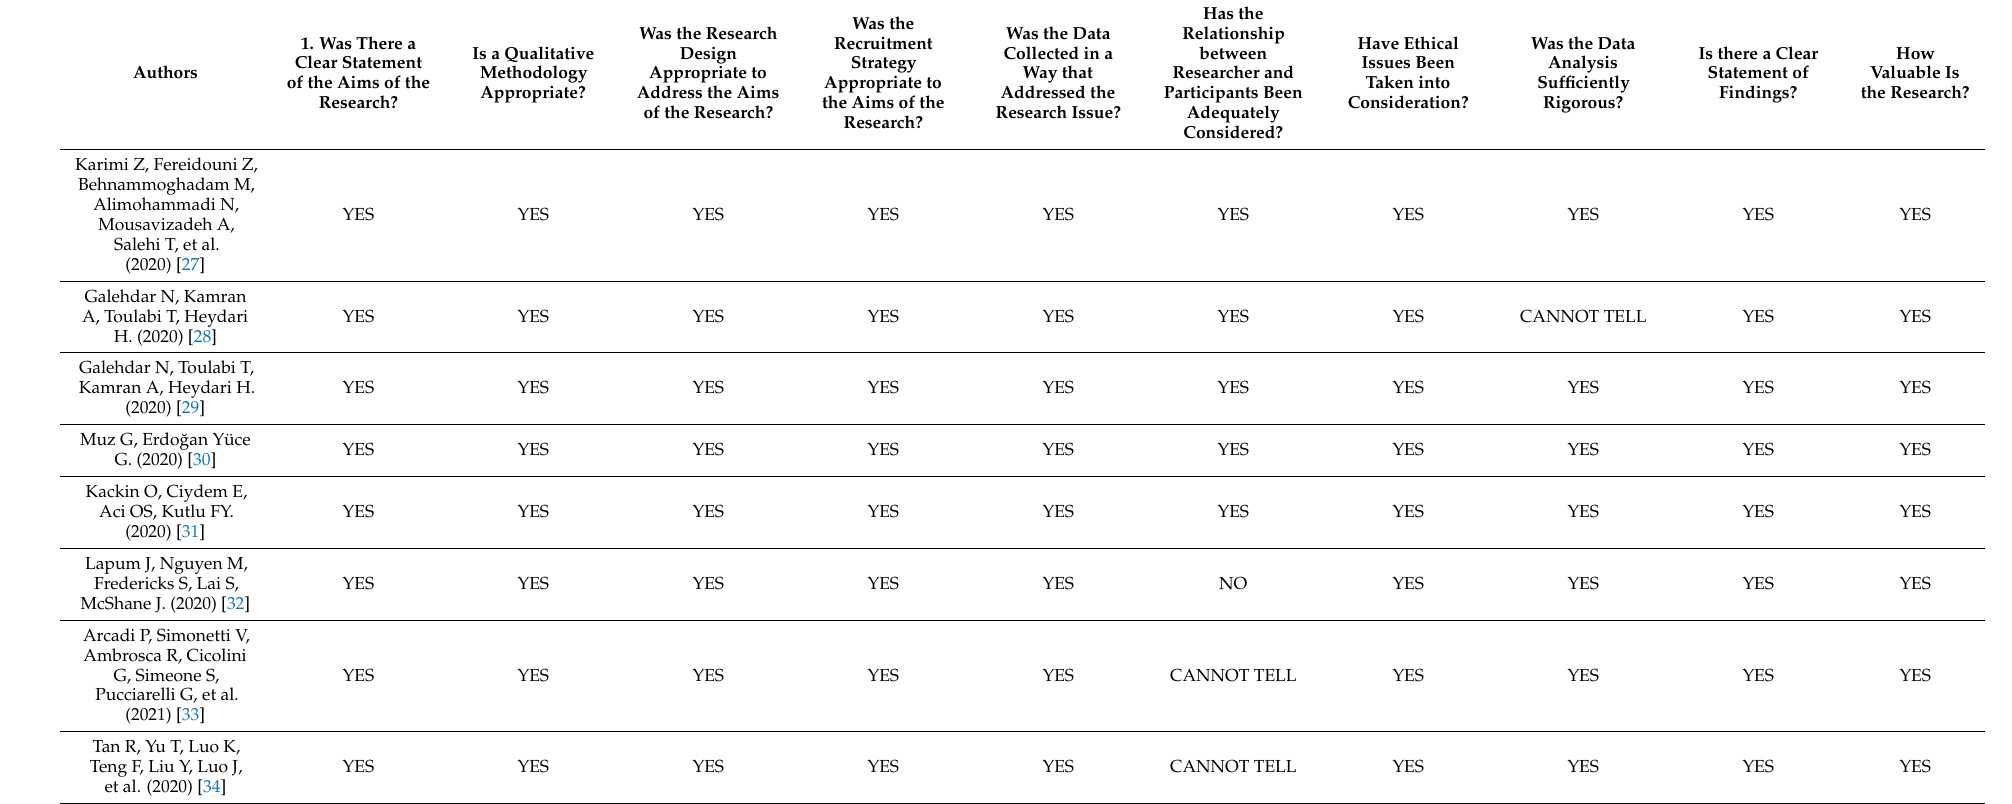
Table 3. Evaluation of the quality of the studies with the CASP tool for qualitative